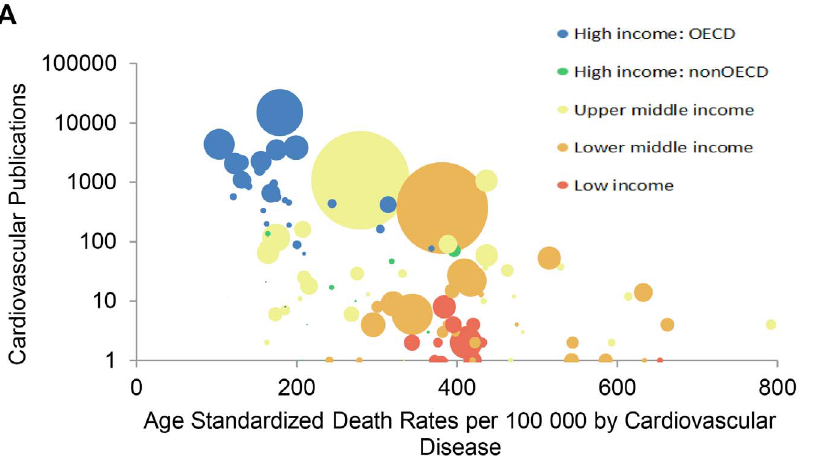
Figure 3. Country-level cardiovascular research publications in 2004 against age standardized death rates per 100 000 (A) and age standardized disability adjusted life year [DALY] rates per 100 000 (B). Color coding representing World Bank country income status. The size of each country’s bubble represents the population size of that country.